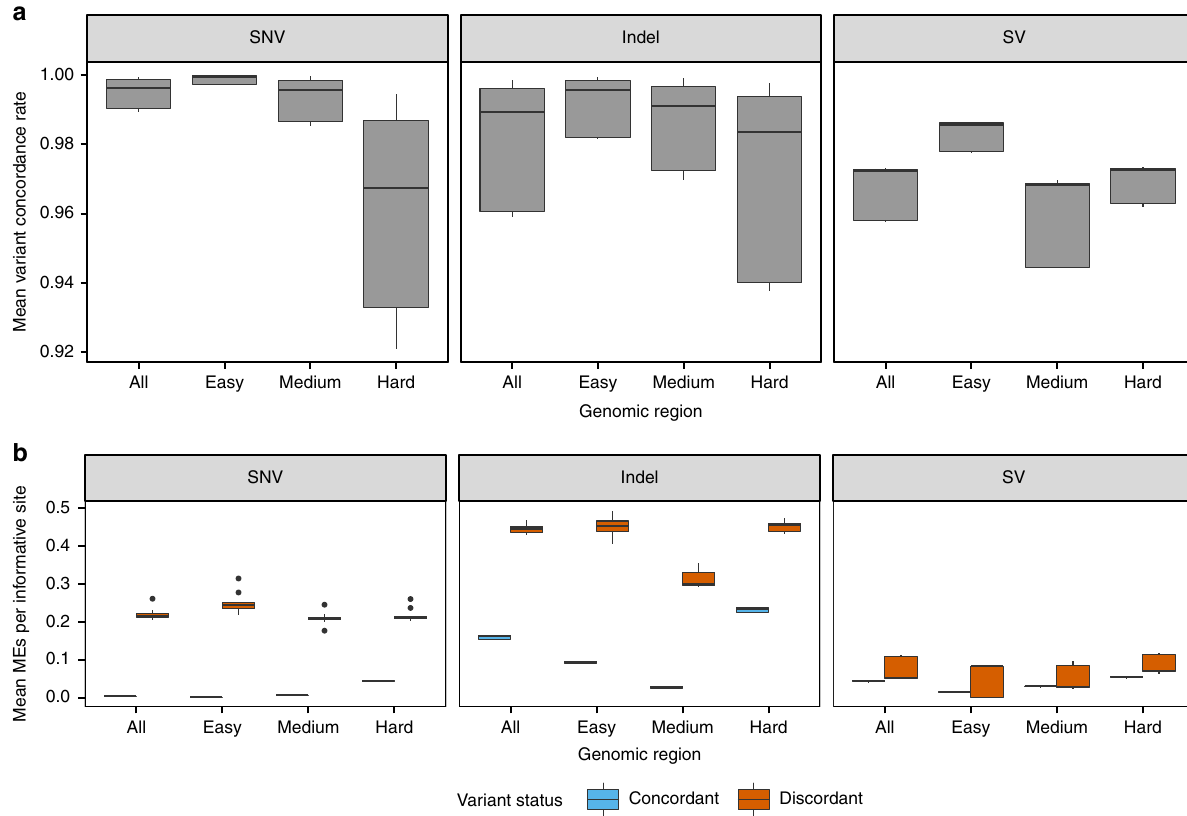
Fig. 3 Variant concordance and Mendelian error (ME) rates were calculated for different variant classes and genomic regions using 100 samples, including 8 trios from the 1000 Genomes Project and 19 quads from the Simons Simplex Collection. a Variant concordance rates were calculated from pairwise comparisons across fi ve pipelines for 100 samples. b Mendelian error rates were calculated using informative sites in 44 parent-offspring trios, for variants classi fi ed as concordant and discordant in pairwise comparisons between fi ve pipelines. The center line is the median, the upper and lower hinges are the fi rst and third quartiles, and the whiskers extend to the largest/smallest values no further than 1.5 * inter-quartile range from the